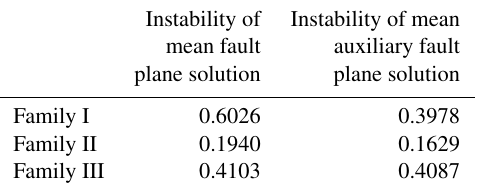
Table 1. Fault instabilities of the mean fault plane solution and its auxiliary plane for each